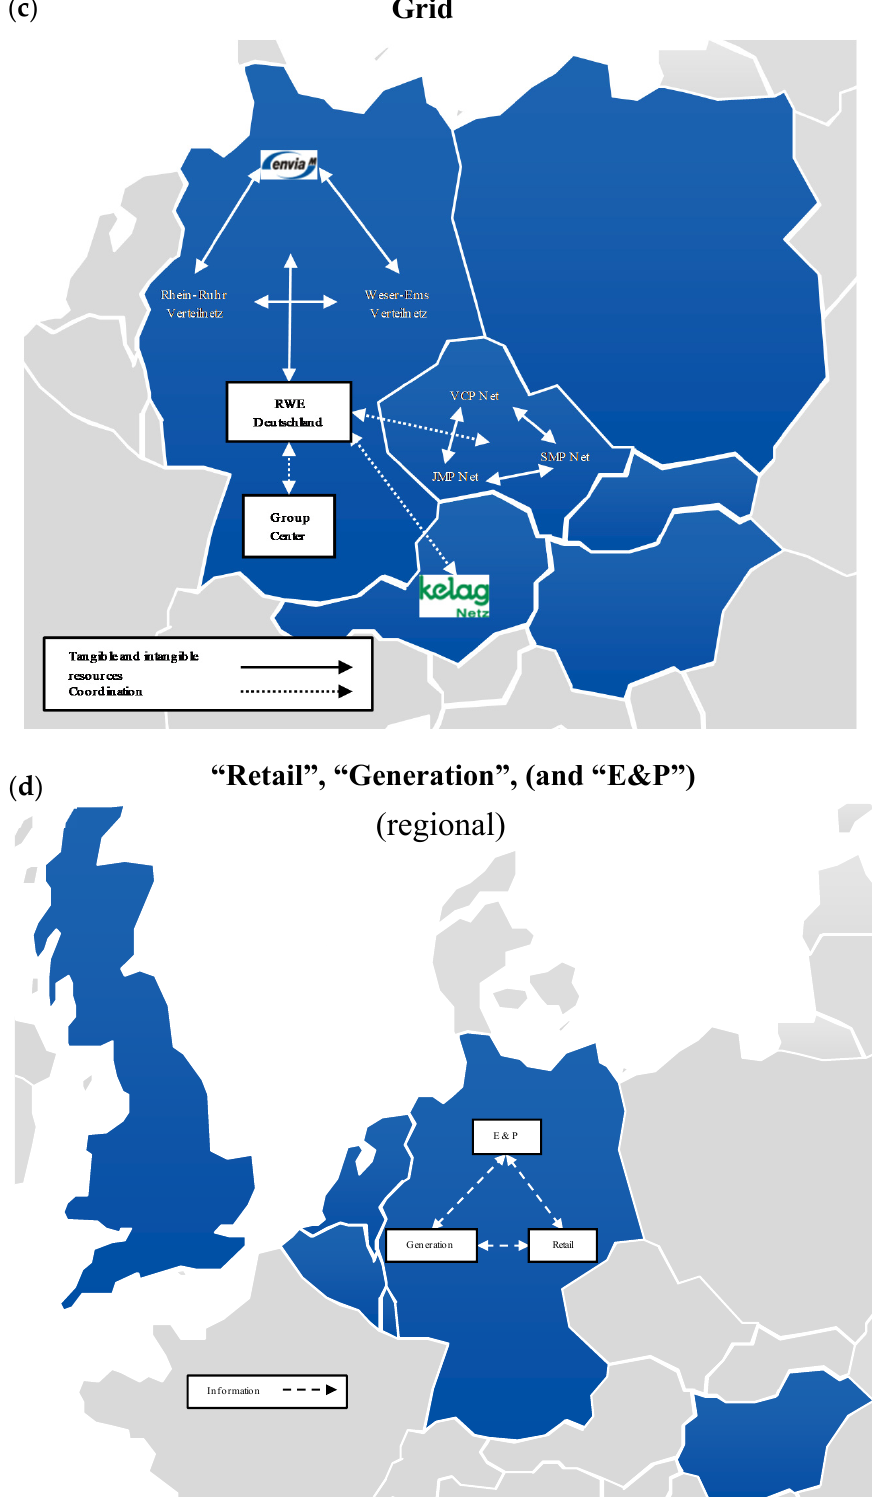
Figure 11. Overview of the main functional synergies within the different asset classes “retail” ( a ), “generation” ( b ), “grid” ( c ), and “E&P” ( d ) (regional and supra-regional), 2012. Own illustration, based on RWE internal information.